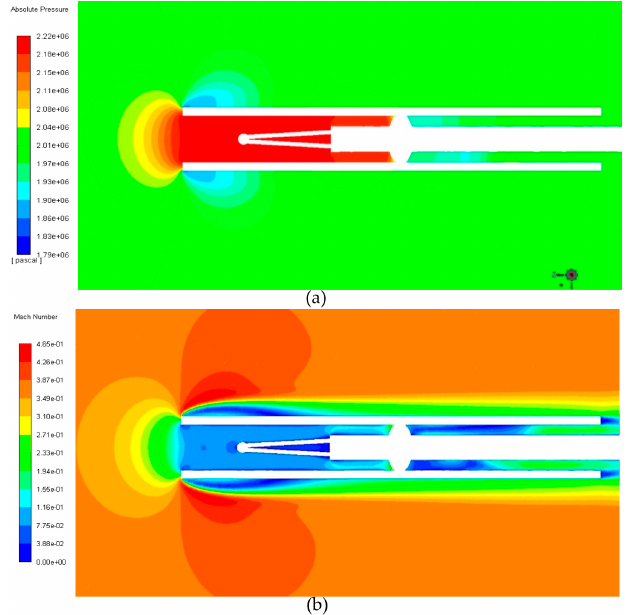
Figure 7. Contour plots of ( a ) pressure and ( b ) velocity distributions for the single-screen thermocouple (SST).